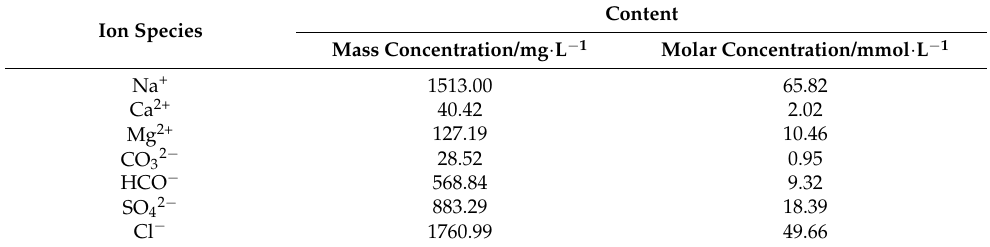
Table 2. Main components of mine water.